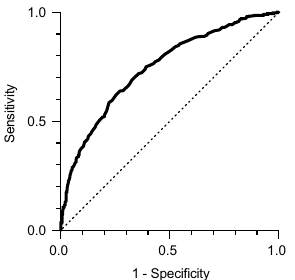
Figure 5. A receiver-operating characteristic (ROC) curve for body weight change after nonalcoholic fatty liver disease (NAFLD) remission to identify NAFLD recurrence (area under the ROC curve = 0.75, p < 0.0001). The cutoff value of weight change was + 1.5 kg (sensitivity 0.64, specificity